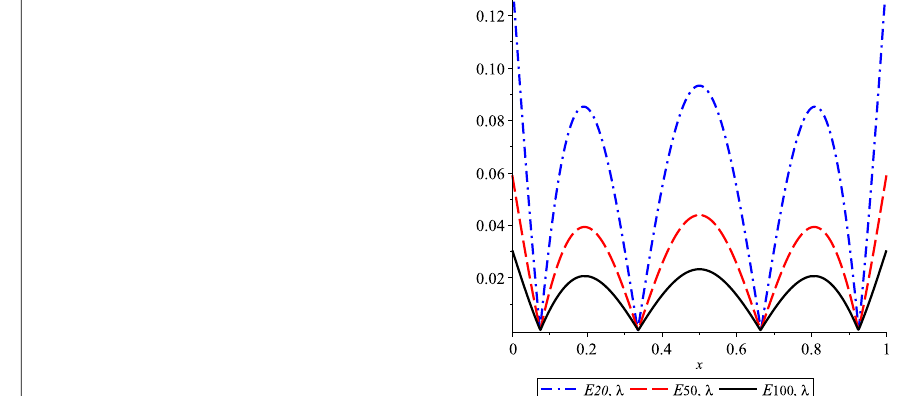
Figure 2 Error of approximation